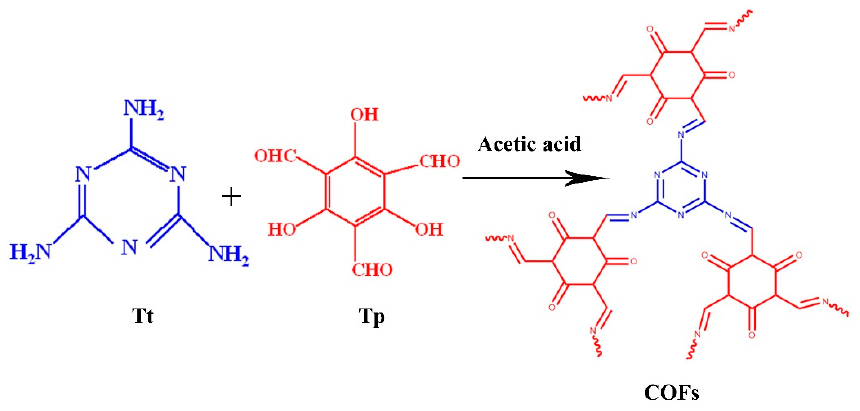
Figure 2. Schematic representation of the COF synthesis.